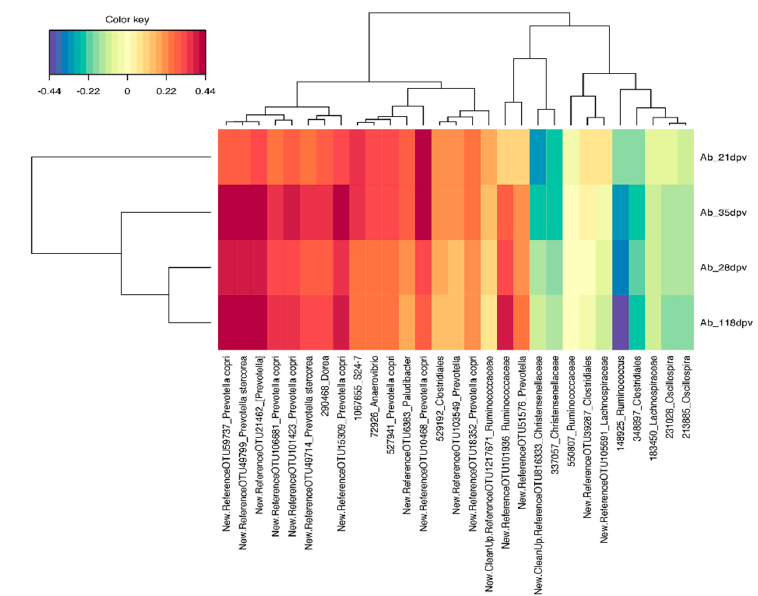
Figure 5. Clustered image map showing the correlation between post-vaccination antibody titers with the pre-vaccination differentially abundant OTUs determined using the 35 dpv classification.